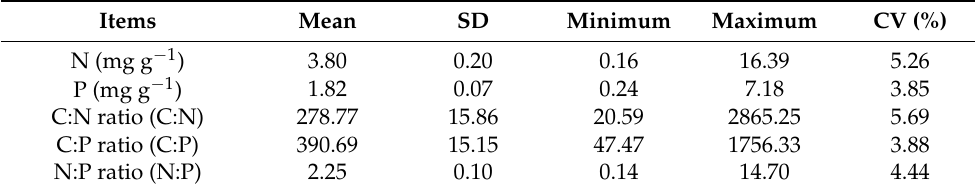
Table 3. Statistics of N and P concentrations and stoichiometric ratios in leaves.